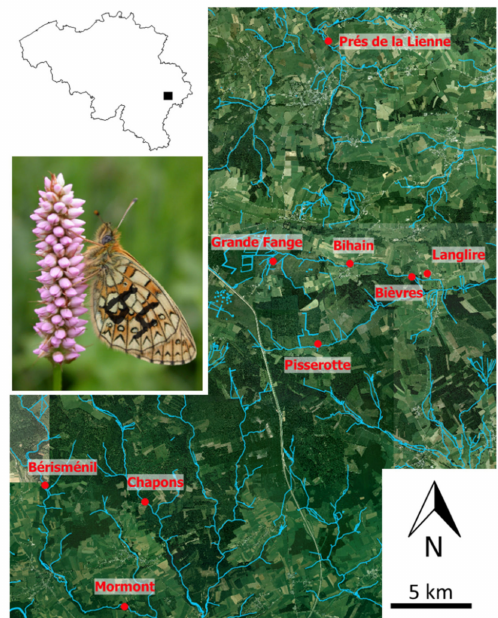
Figure 1. Model species and study area. The studied metapopulation is situated in the Ardenne region, southeastern Belgium (up-left map); the location of the nine local populations are represented in red on an aerial view of the region. On the left of the map, we provide a picture of one marked Boloria eunomia butterfly on an inflorescence of P. bistorta , its host